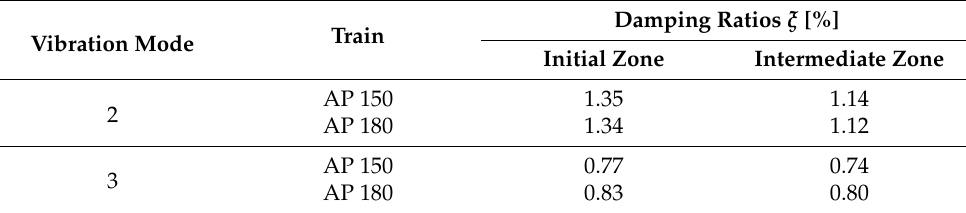
Table 4. Damping ratios values for modes 2 and 3 depending on the vibration